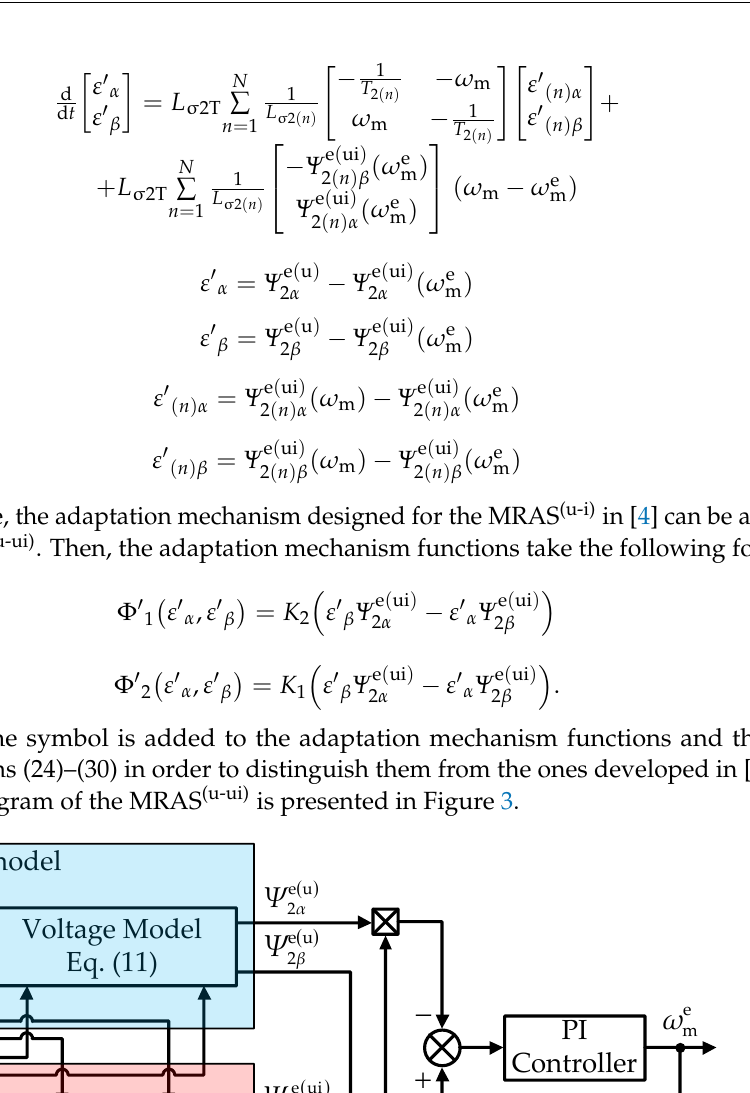
Figure 3. The schematic diagram of the MRAS (u-ui) .